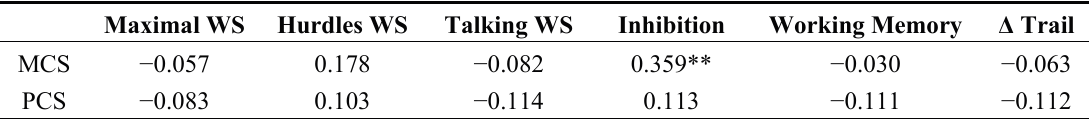
Table 2. Results of correlation analysis (Pearson’s r) between functional mobility (WS = walking speed) and executive function (Inhibition, Working memory, Cognitive flexibility ( Δ Trail)) measures and the mental (MCS) and physical (PCS) components of HRQoL. Maximal WS Hurdles WS Talking WS Inhibition Working Memory Δ Trail MCS − 0.057 0.178 − 0.082 0.359** − 0.030 − 0.063 PCS − 0.083 0.103 − 0.114 0.113 − 0.111 − 0.112 Note: ** p = 0.007.